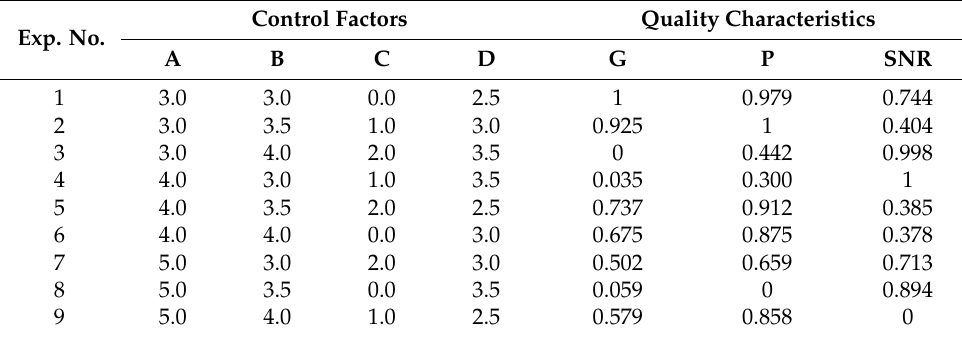
Table 4. Normalization of the different quality characteristics.